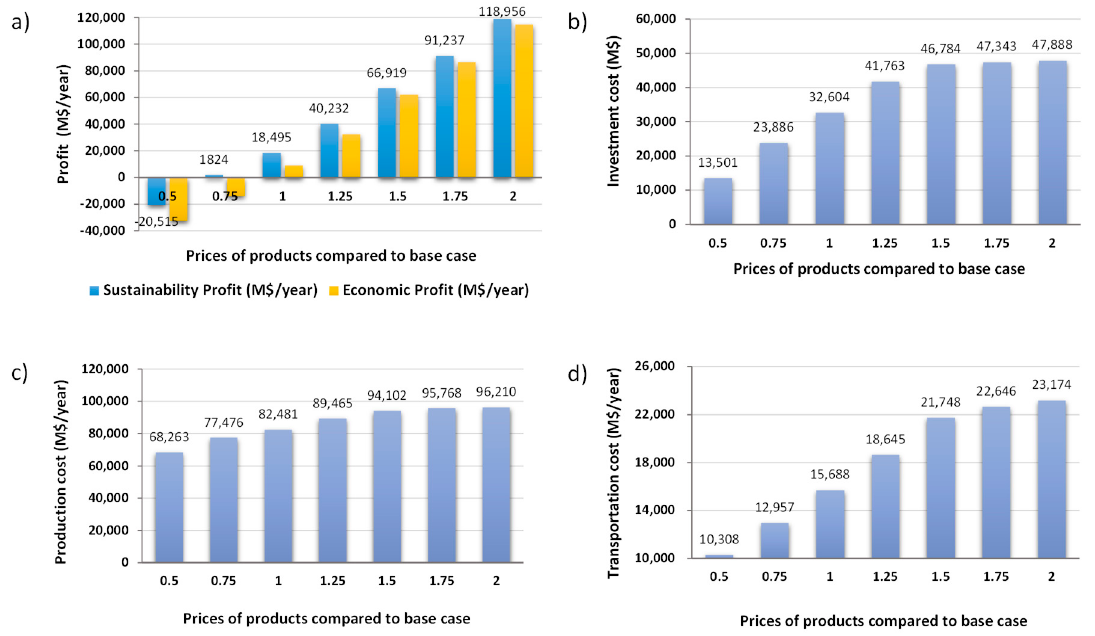
Figure 10. Influence of product selling prices on ( a ) sustainability and economic profit, ( b ) investment cost, ( c ) production cost, and ( d ) transportation cost.